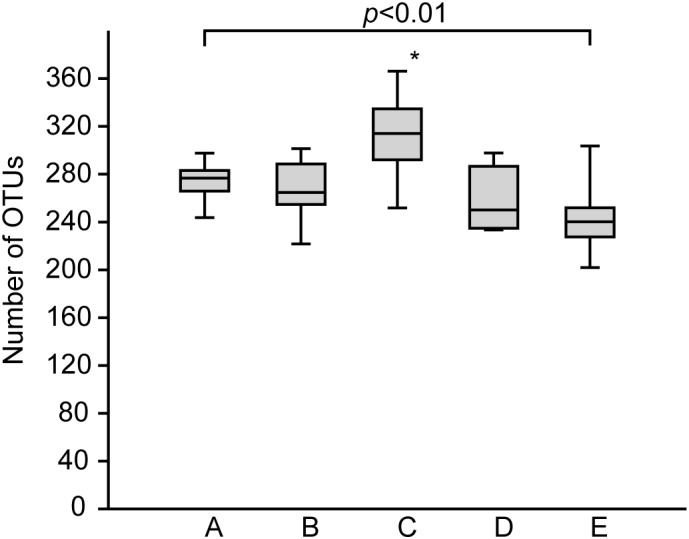
Boxplots showing the rarefied and bootstrapped number of operational taxonomic units (OTUs) at the different sampling stations. The boxplots show the 25–75 percent quartiles; the median is indicated by the horizontal line inside the box. A (Skagerrak, salinity 35, n = 14), B (Belt Sea, salinity 21, n = 15), C (Baltic Proper, salinity 8, n = 15), D (Bothnian Sea, salinity 7, n = 9), E (Bothnian Sea, salinity 4, n = 13). See also Figure 1 for an overview. The asterisk indicates significant differences (Tukey p < 0.01) between station C and stations A, B, D, and E. Station E was significantly different from station A.